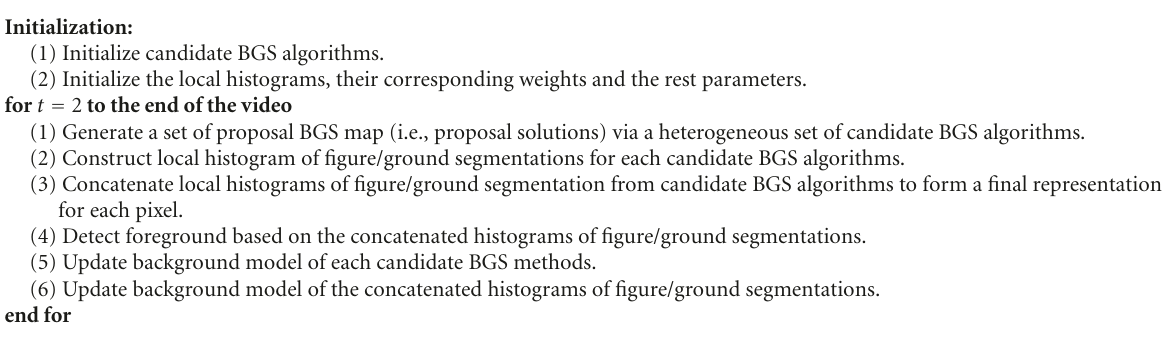
Algorithm 1: Local histogram of figure/ground segmentations for dynamic background